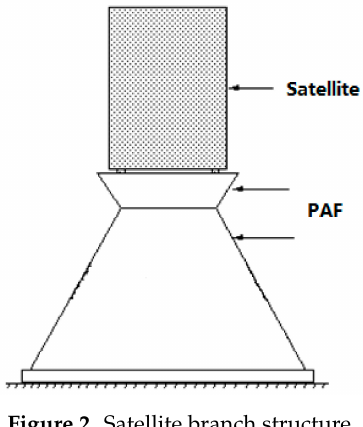
Figure 1. The sketch of the whole-spacecraft vibration isolation system.